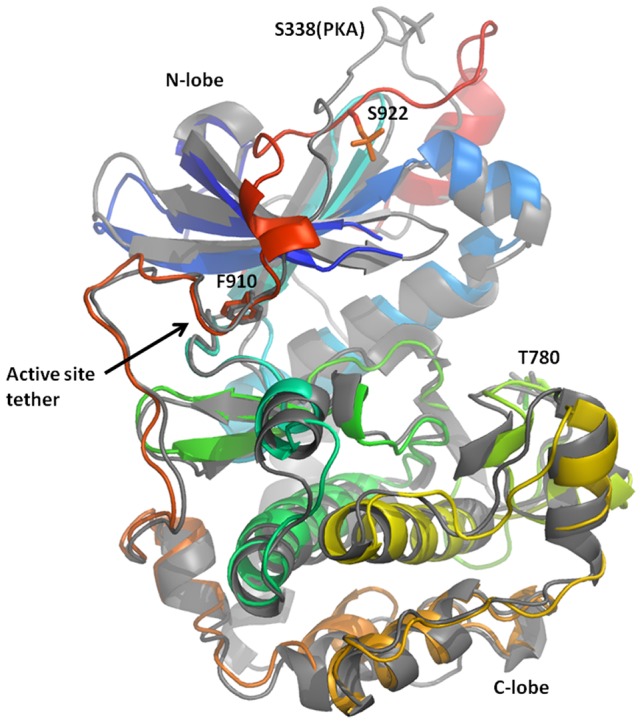
Comparison of PRK1 to PKA.The structure of PRK1 is shown colored from blue to red (N- to C- terminus); PKA (1BKX) is shown in grey. Sites of phosphorylation (PRK1 residues S922 and T780, PKA residue S338) are shown as sticks, as is active site tether residue F910 (PRK1). The structures show good alignment, with a divergence in the conformation of the C-tail as it passes over the N-lobe.